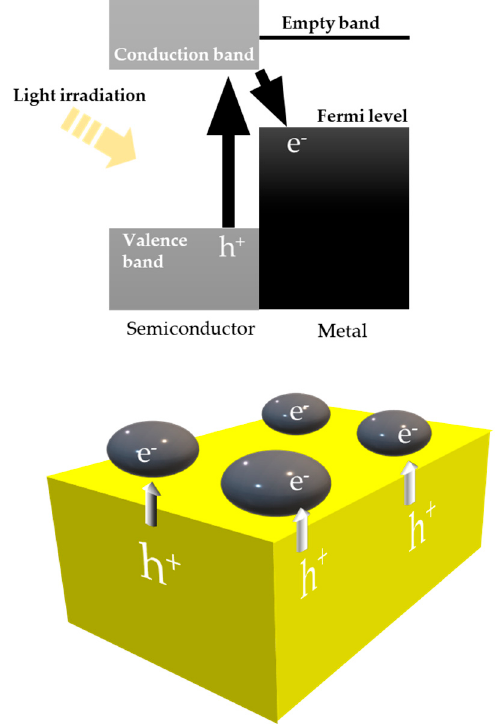
Figure 3. General electron transfer pathway in a metal-loaded semiconductor after light irradiation.